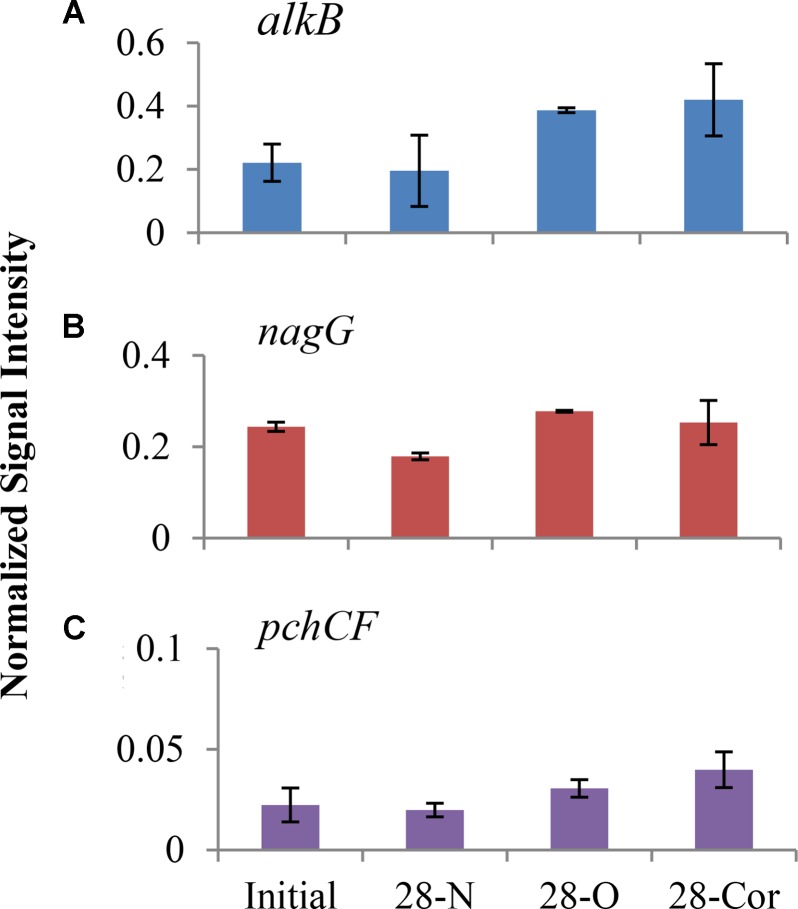
Normalized signal intensity of alkB
(A), nagG
(B), and pchCF
(C) genes in offshore experiment at day 0 and 28 (2°C; n = 3). Bottles contained seawater (800 mL), and either no amendment (N), oil (O; 15 mg/L), or Corexit 9500 (Cor; 15 mg/L). Error bars are standard deviations.